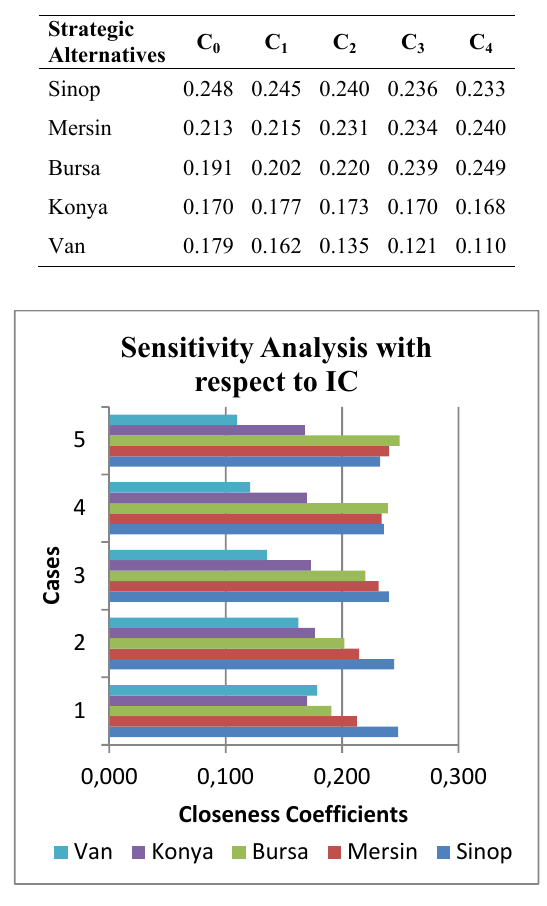
Fig. 5 Sensitivity Analysis with respect to IC considered cases